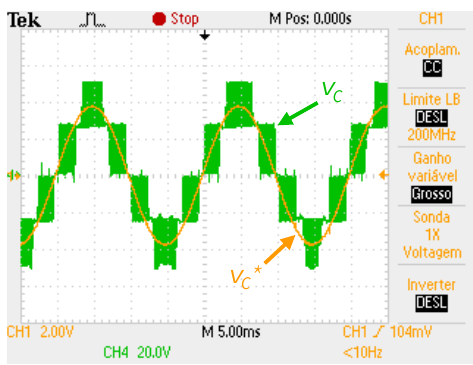
Figure 24. Experimental results of the modified multilevel SPWM modulation technique: Converter reference voltage ( v c *) and converter voltage ( v c ).